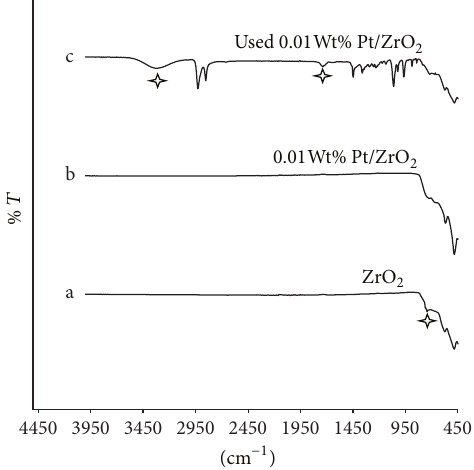
Figure 4: FT-IR spectra of (a) monoclinic ZrO 2 , (b) Pt/ZrO 2 , and (c) after reaction unwashed Pt/ZrO 2